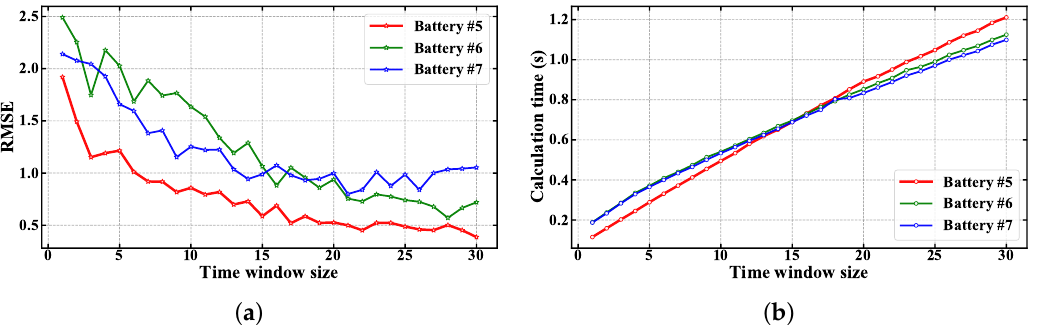
Figure 9. Results of experimental case 1. The RUL prediction results of Batteries #5, #6 and #7 when using the PSO-GBDT method with different window sizes: ( a ) RMSE at different window sizes. ( b ) The total calculation time required for training and prediction at different window